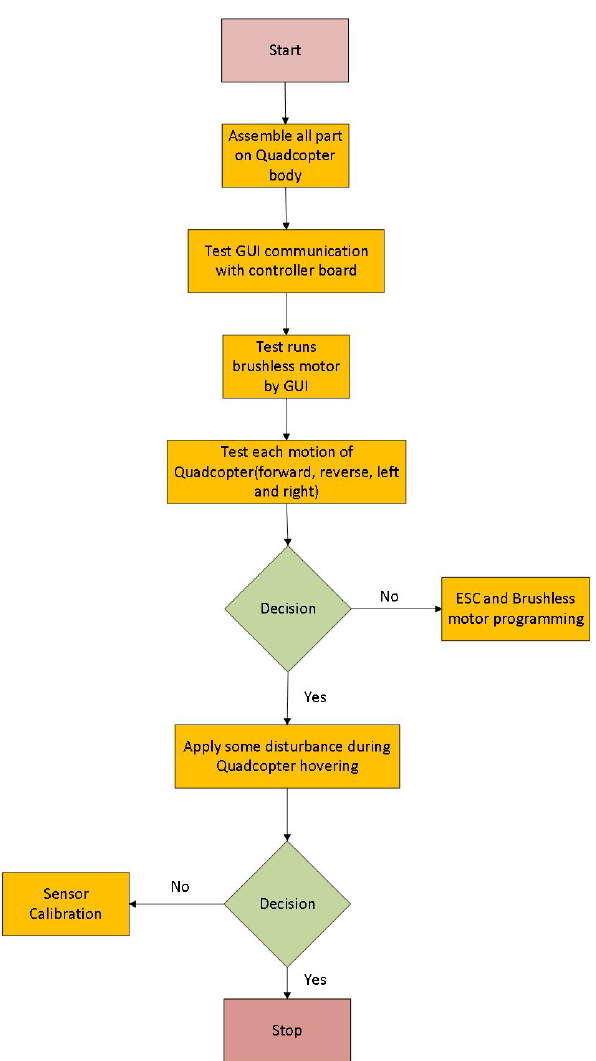
Figure 3. Flow chart of assembling and testing